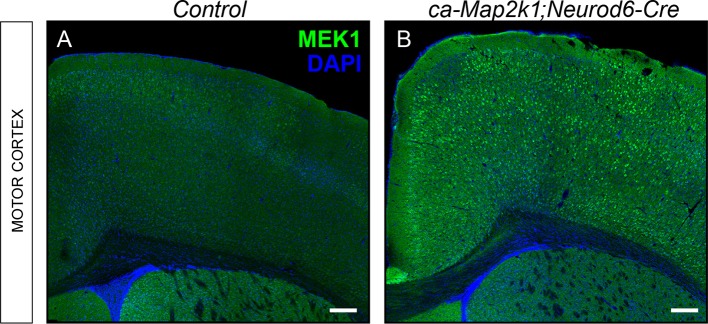
Mouse model for excitatory neuron specific gain-of-ERK/MAPK signaling in the cortex.(A–B) Representative confocal images of forebrain sections from controls (A) and ca-Map2k1;Neurod6-Cre mutants (B) demonstrate that the expression of MAP2K1 is substantially higher in excitatory neurons across all layers of the cortex, but not in the striatum (n=4, scale bar=100 µm).